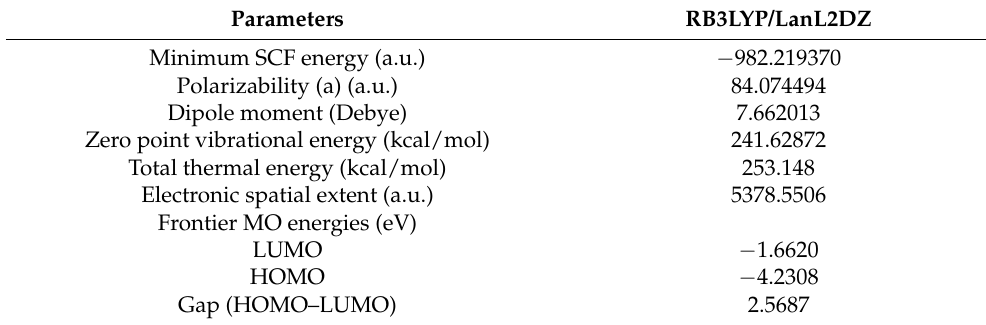
Table 8. The various other theoretical molecular parameters of the metal complex [Cu(II)–(Gpn)].